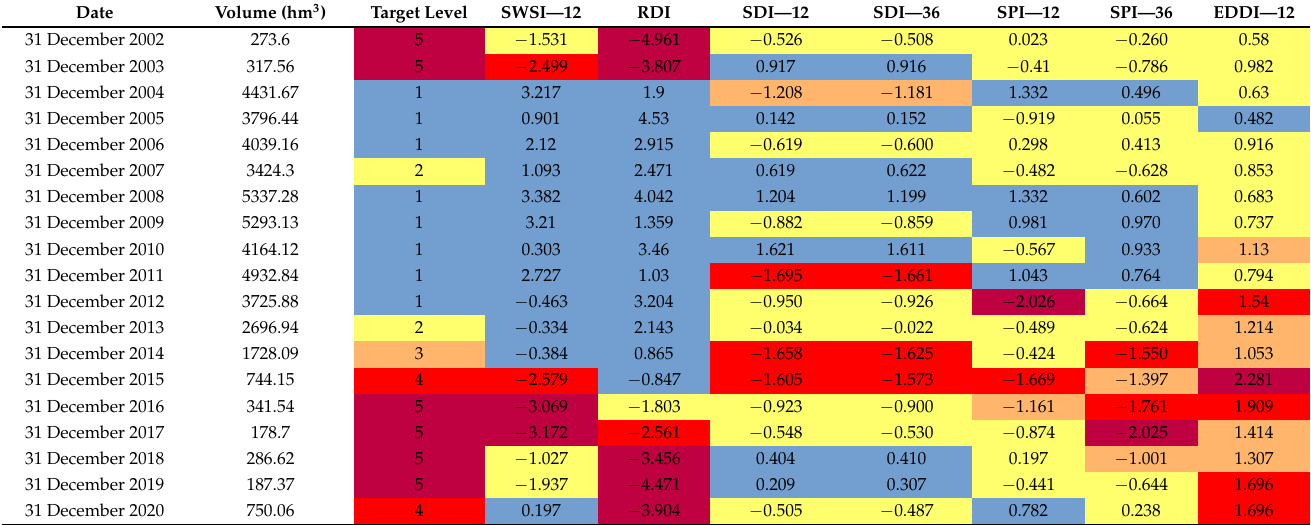
Table 11. Analysis of the indexes in relation to the Target Levels for the Castanh ã o